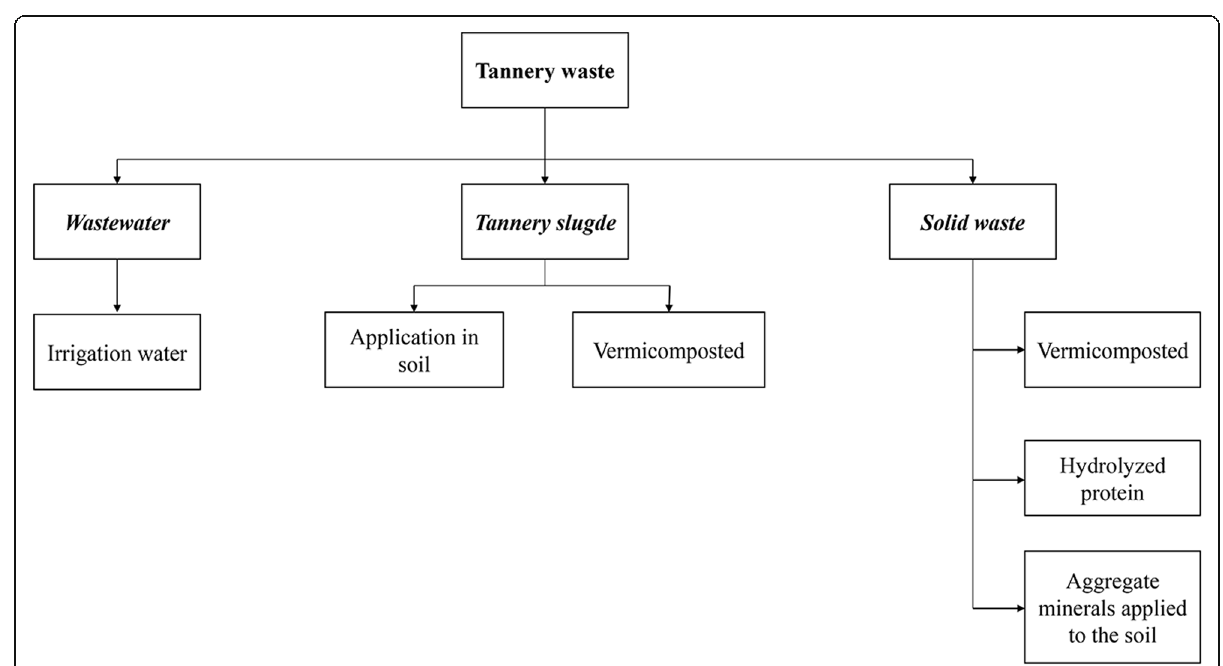
Fig. 5 Origin and destination of tannery wastes for application in